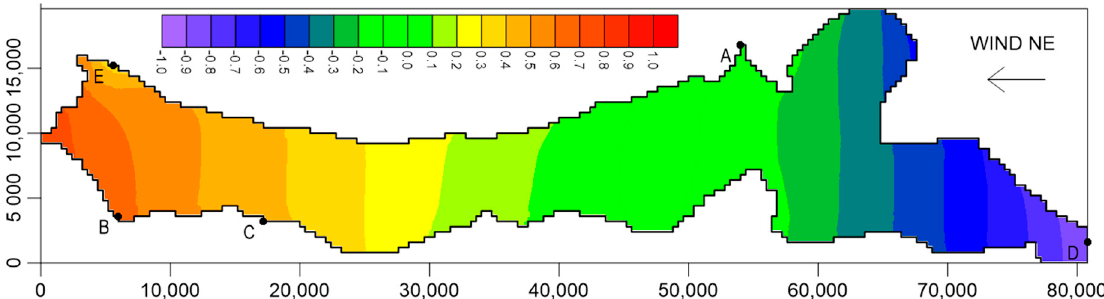
Figure 9. Water surface elevation (m a.s.l.) after 12 h of a NE wind at a speed of 12 m s − 1 and with the new artificial strait at point E (dimensions in meters).